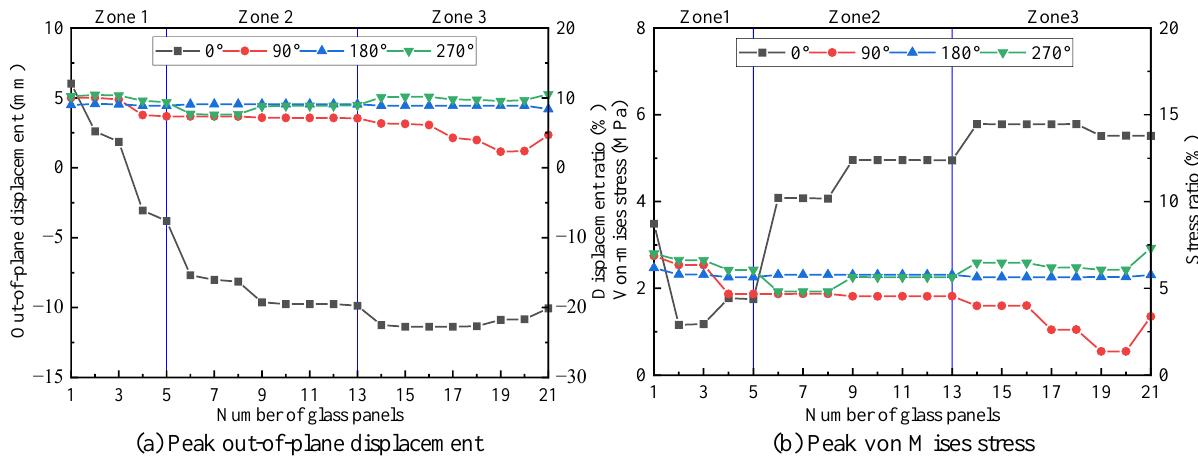
Figure 7. Peak responses of inner glass panels.